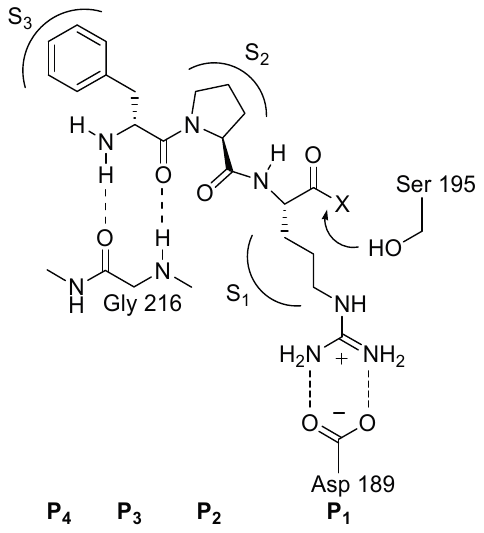
Figure 2. Schematic representation of the binding mode of a D -Phe-Pro-Arg type inhibitor to the active site of